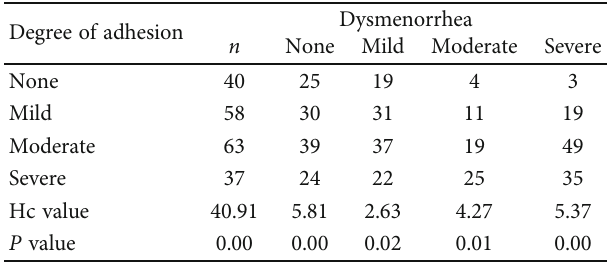
Table 3: The relationship between the degree of pelvic adhesion and pain.